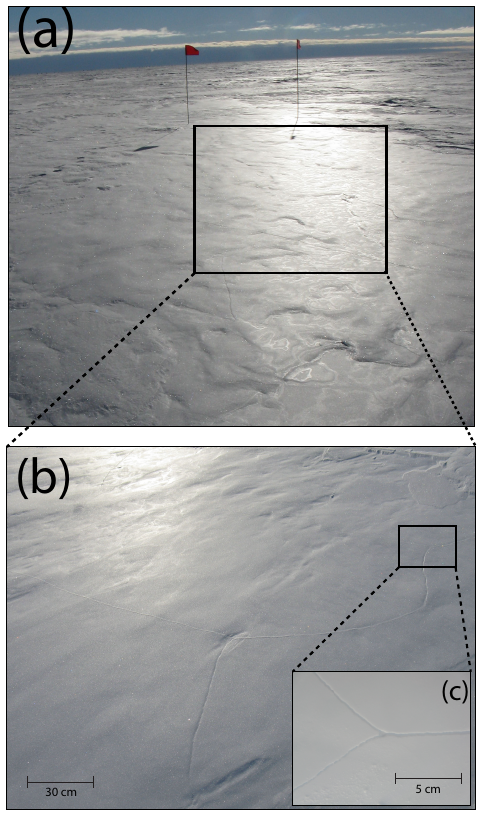
Figure 4. Surface “glaze” seen at the WAIS Divide site (a) . A zoomed-in view shows the polygonal cracking that initiates at the surface from thermal contraction, following several sunny, clear-sky days (b) . Closer inspection reveals greater detail and scale of a crack triple junction (c)